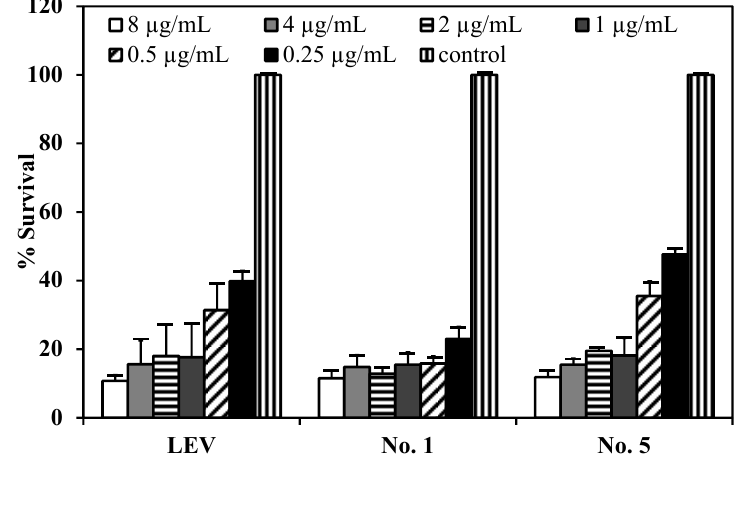
Figure 8. The reduction of M. bovis (% survival) after incubation with ( a ) LEV; ( b ) LEV-proliposome formulation No. 1; and ( c ) LEV-proliposome formulation No. 5 at different concentrations for 6 days (Mean ± SD, n ≥